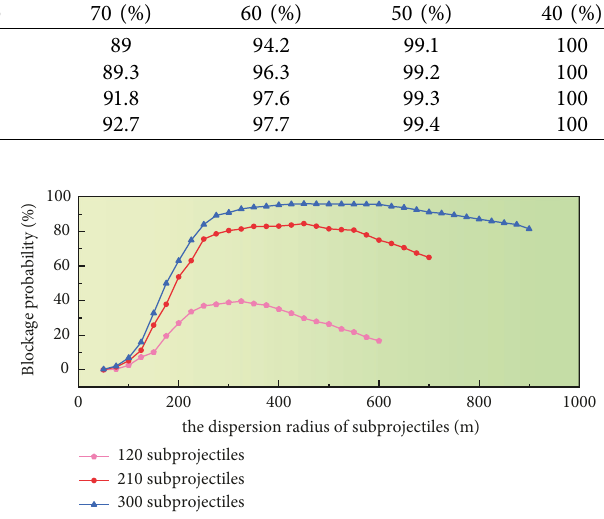
Figure 16: Influence of the dispersion radius of subprojectiles on the blockage probability under different numbers of